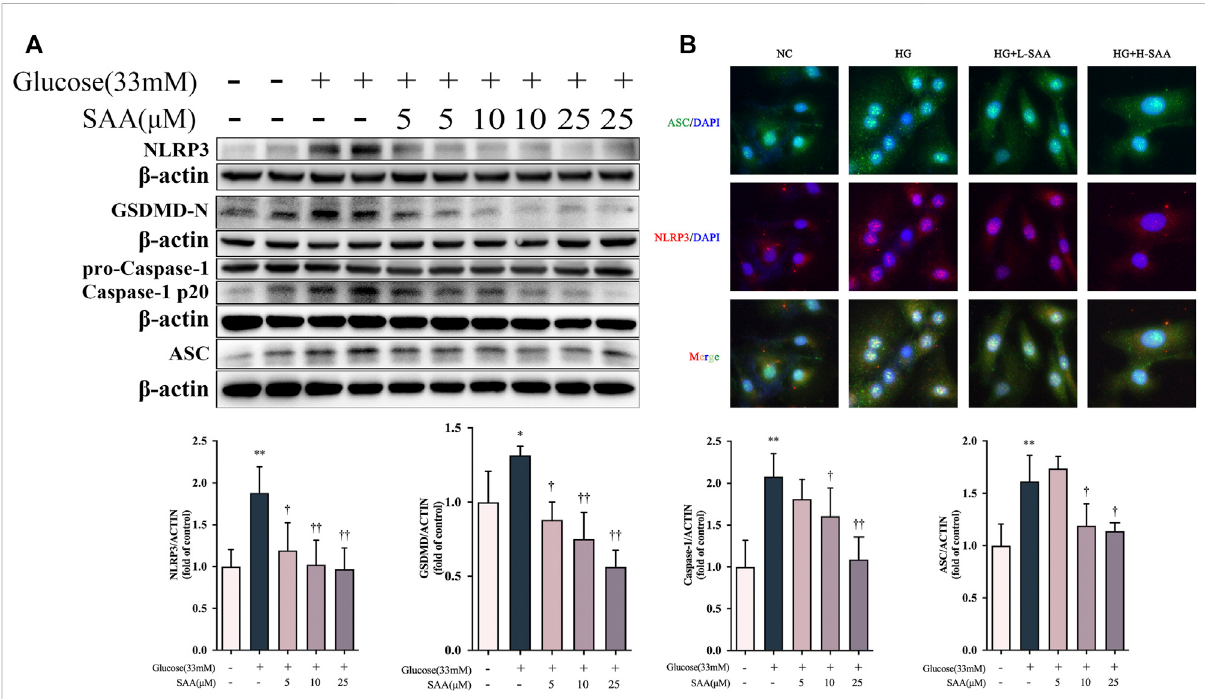
SAA inhibited high glucose-induced pyroptosis in HUVECs. (A) Expression levels of NLRP3, ASC, caspase-1, GSDMD and ß -Actin in HUVECs weredeterminedbywesternblot. (B) CellularlocalizationofNLRP3andASCwasanalyzedbyimmuno fl uorescencestaining.Dataofwesternblotare the representatives of four independent experiments. Date of histograms are represented as mean ± SD of three independent experiments. * p < 0.05, ** p < 0.01 vs. control group. † p < 0.05, †† p < 0.01 vs. high glucose